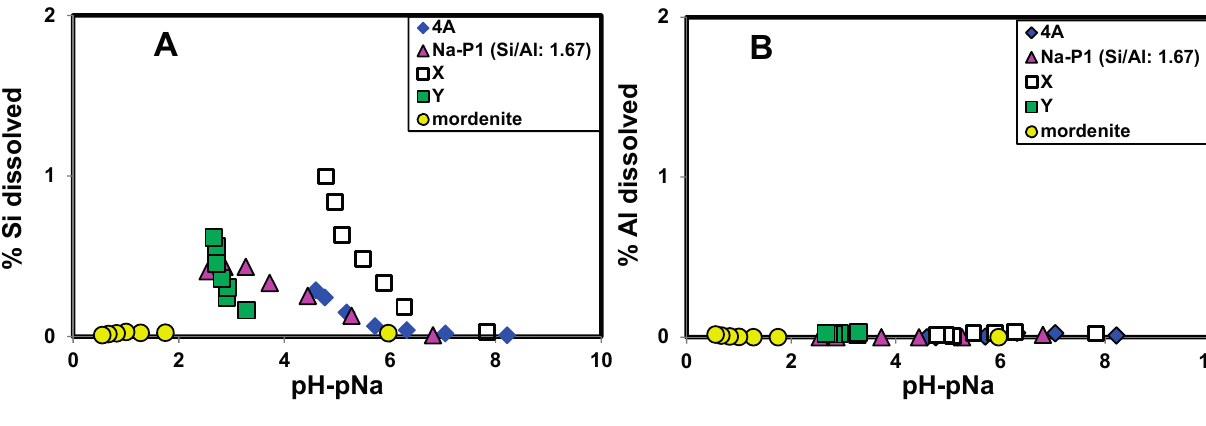
Figure 2. Effect of pH − pNa on the dissolution of Al and Si from zeolites. ( A ) Plots of % Si dissolved. ( B ) Plots of % Al